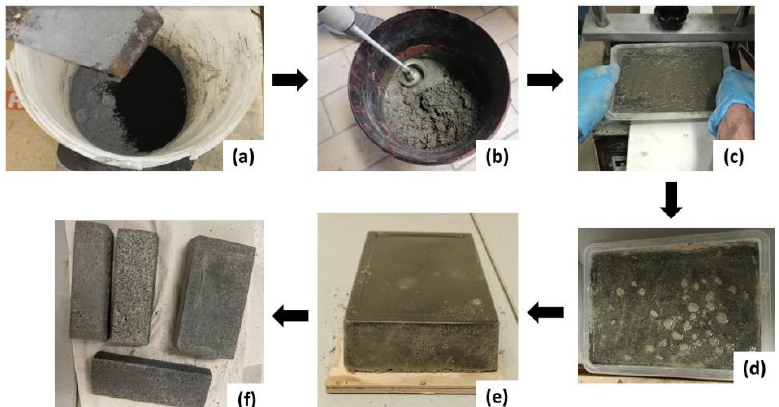
Figure 9. Phases of the mold-casting manufacturing process: ( a ) dry constituents mixing, ( b ) drill mixing of the fresh paste, ( c ) pouring in the polypropylene mold and vibrating cycles, ( d ) curing, ( e ) de-molding of the hard-state slab, and ( f ) cutting of the specimens for the material’s characterization.